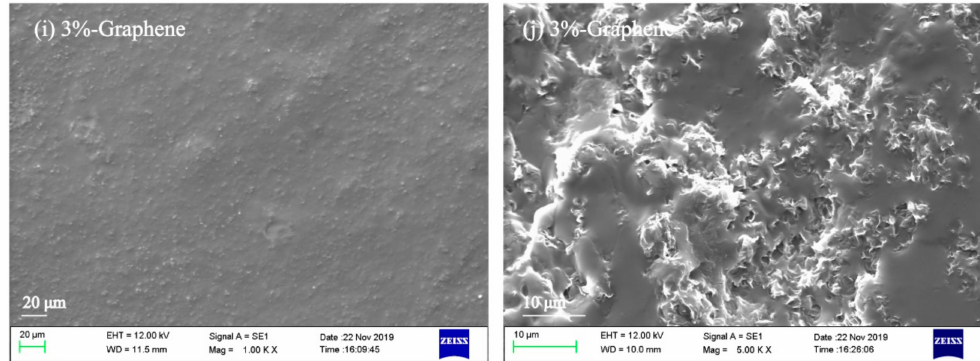
Figure 2. Scanning electron microscopy (SEM) images of ( a ) graphene oxide (GO) (1000 × ) and ( b ) graphene(20000 × ), and representative SEMimages ofthe blendfilms: ( c ) 1%-GOsurface morphology (1000 × ), ( d ) 1%-GO fracture morphology (5000 × ), ( e ) 3%-GO surface morphology (1000 × ), ( f ) 3%-GO fracture morphology (5000 × ), ( g ) 1%-Graphene surface morphology (1000 × ), ( h ) 1%-Graphene fracture morphology (5000 × ), ( i ) 3%-Graphene surface morphology (1000 × ), and ( j ) 3%-Graphene fracture morphology (5000 ×